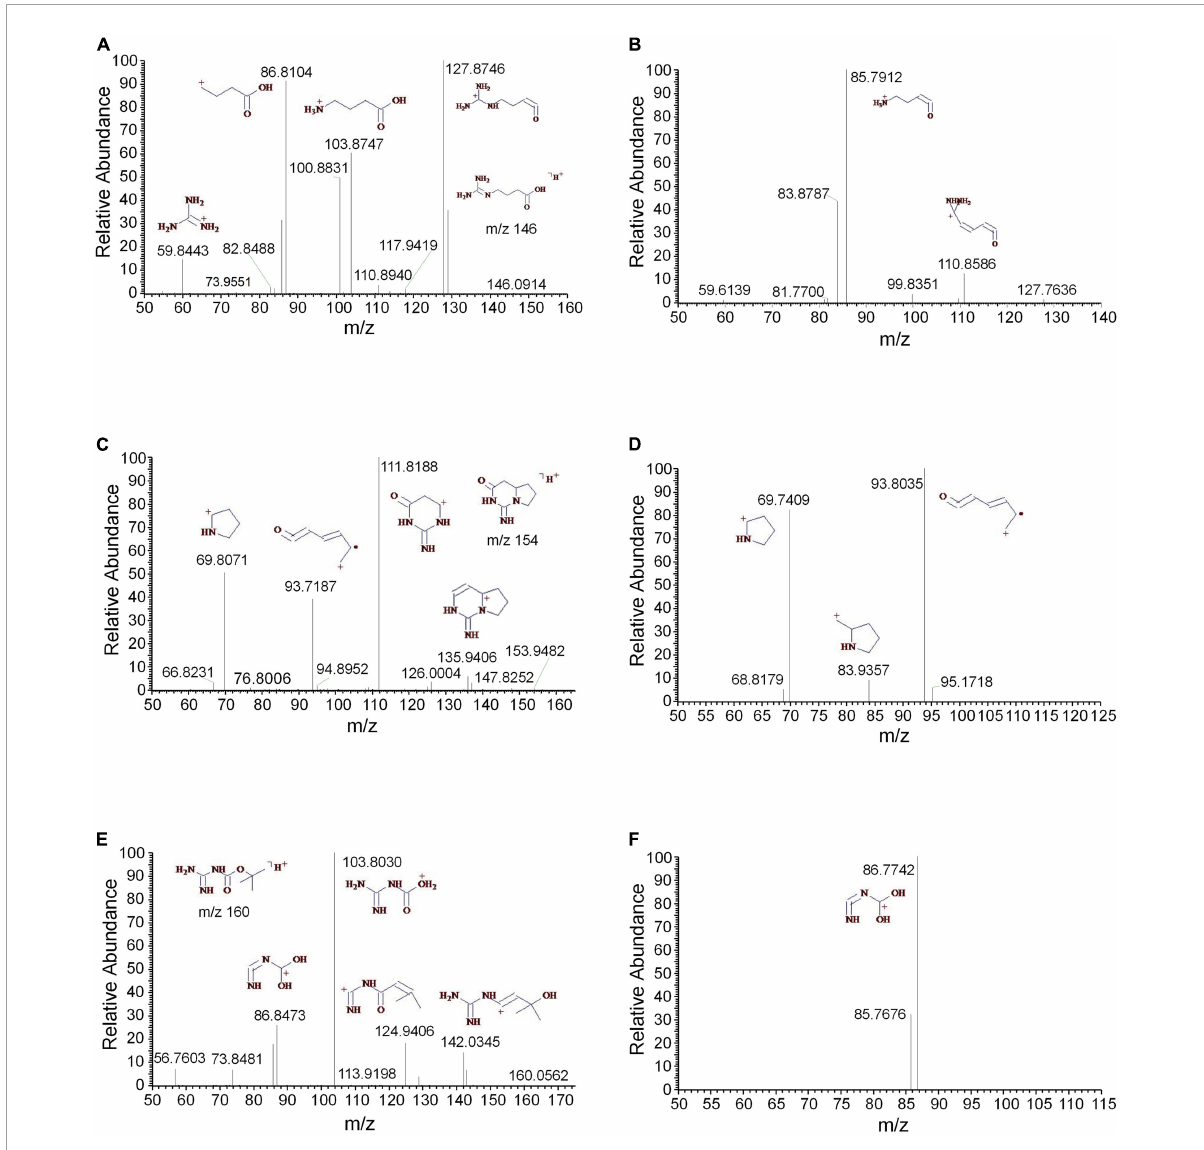
FIGURE6 The mass spectra of the guanidines. (A) The MS 2 spectrum of 4-guanidinobutanoic acid, (B) the MS 3 spectrum of 4-guanidinobutanoic acid, (C) the MS 2 spectrum of cyclocimipronidine, (D) the MS 3 spectrum of cyclocimipronidine, (E) the MS 2 spectrum of N - tert -butyloxycarbonyl guanidine, and (F) the MS 3 spectrum of N - tert -butyloxycarbonyl